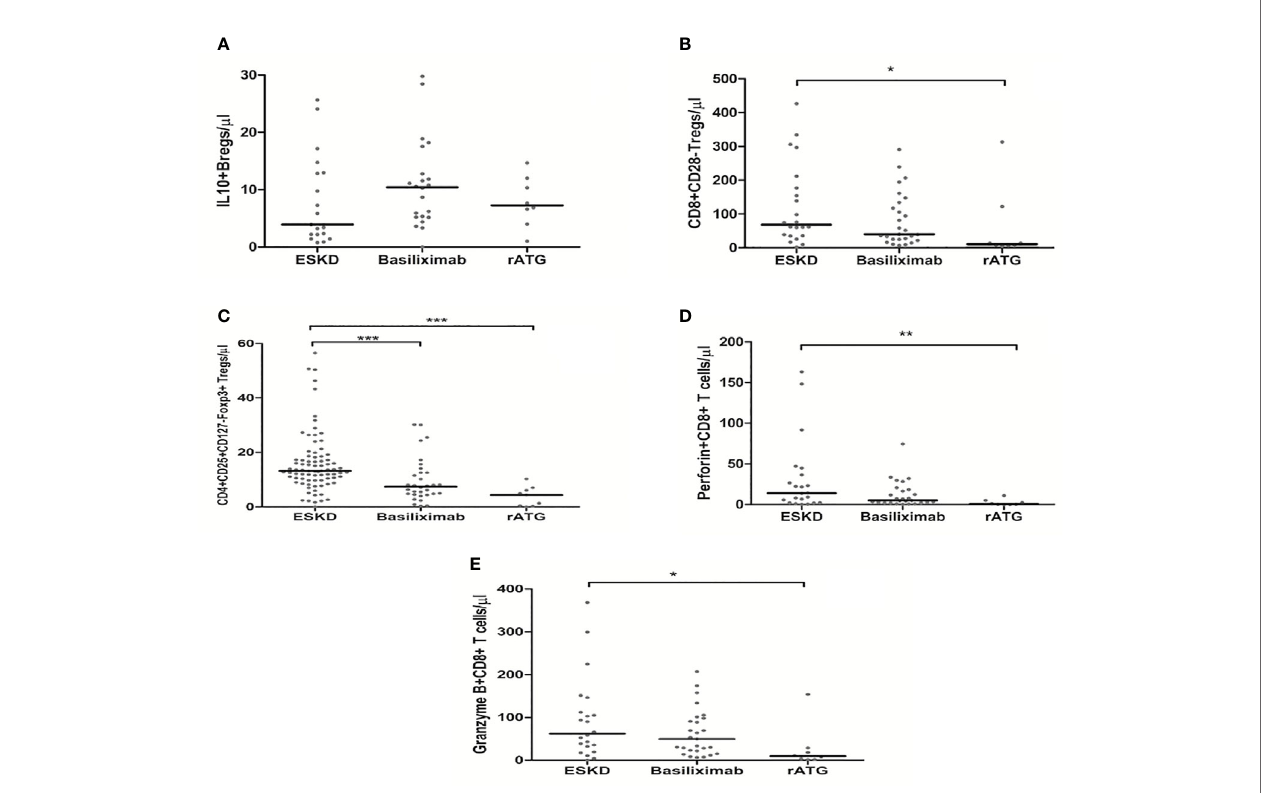
FIGURE 5 | Comparison of the absolute counts of CD19+IL-10+ Bregs (A) , CD8+CD28- Tregs (B) , CD4+CD25+CD127-Foxp3+ Tregs (C) , perforin+ CD8+ T cells (D) , and granzyme B+ CD8+ T cells (E) among the ESKD patients and early Tx recipients, who received antibody induction with either basiliximab or rabbit ATG (rATG): Medians were compared among the groups with Kruskal-Wallis test and p-values were adjusted after correction for multiple comparisons, *p < 0.05, **p < 0.01, ***p < 0.001.